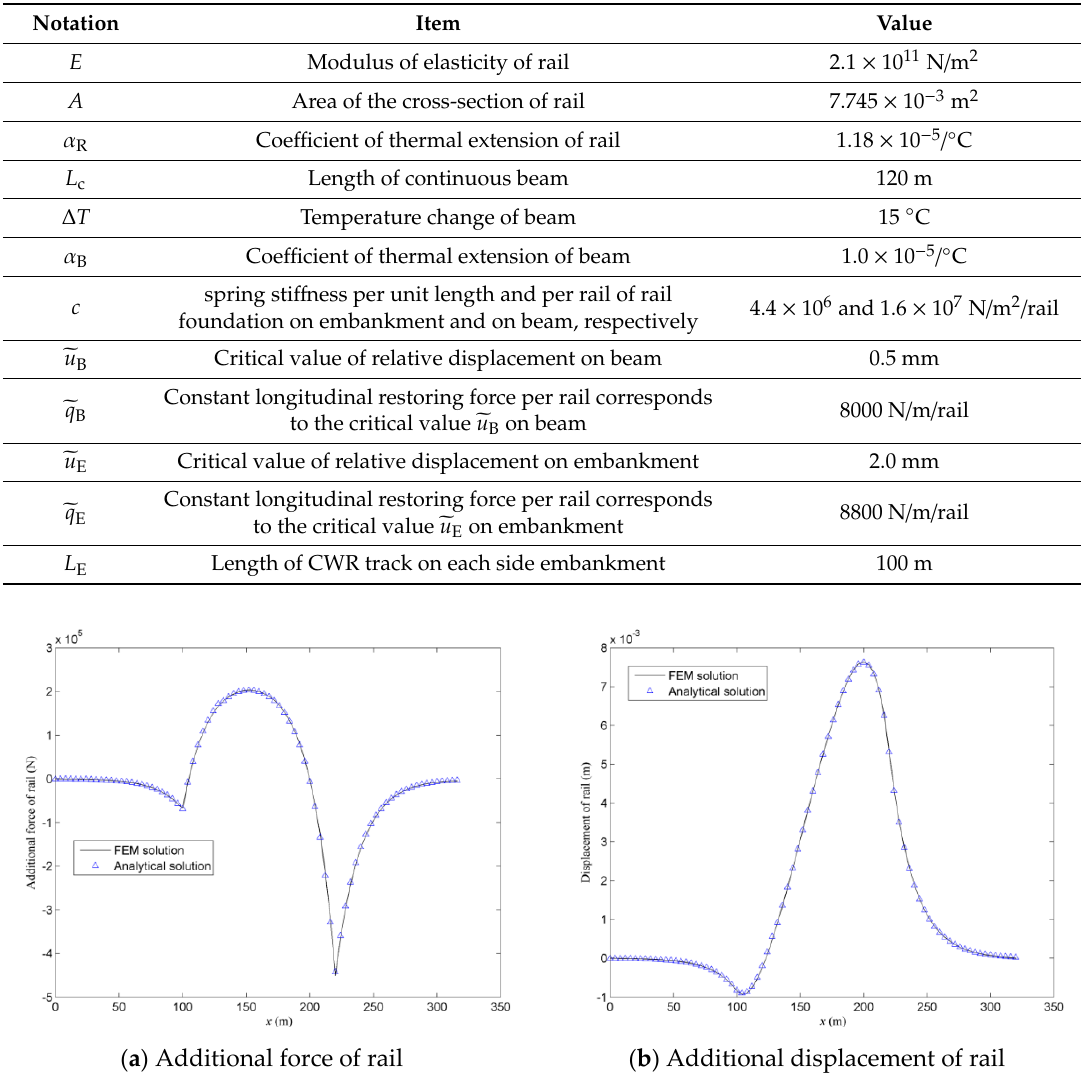
Table 1. The CWR track parameters on continuous beam and embankment.